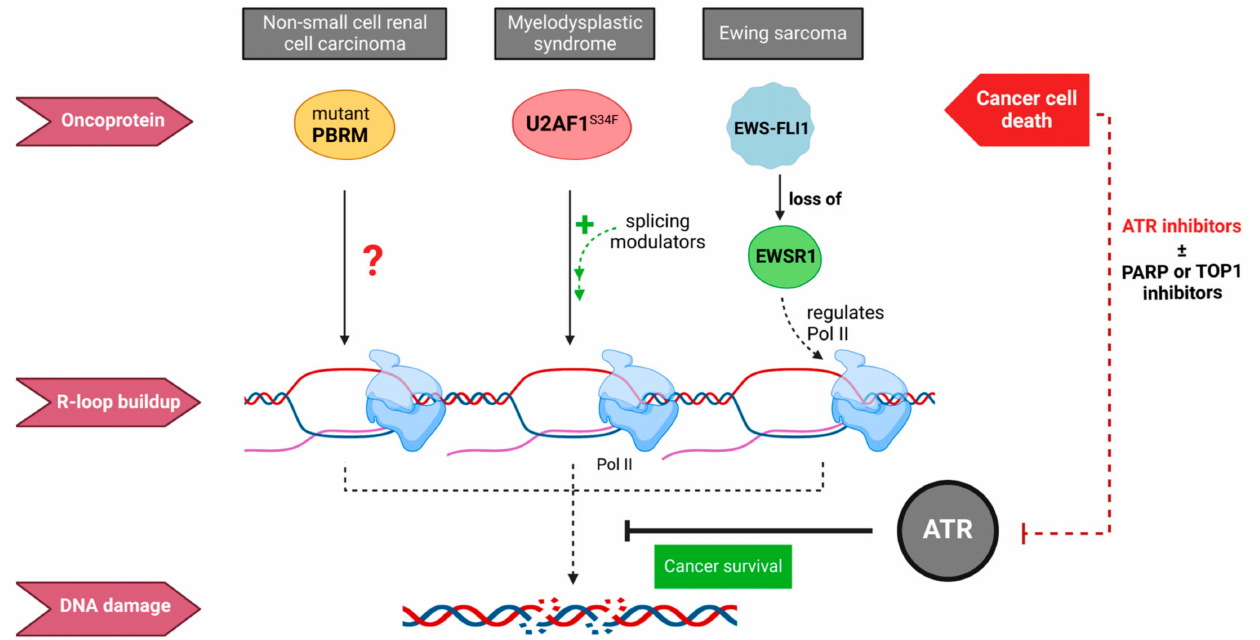
Figure 5. ATR inhibition induces cancer cell death through accumulation of R-loops. Non-small cell renal cell carcinoma caused by PBRM mutations [81], myelodysplastic syndrome caused by a splicing defect in U2AF1 [30], and Ewing sarcoma caused by EWS-FLI1 oncogene fusion [80] and subsequent loss of intact EWSR1 all display increased R-loop levels. Mechanistic details are unclear in PBRM mutations, hence the question mark. Splicing modulators further increase R- loops accumulation in myelodysplastic syndrome cells. A loss of the EWSR1 regulatory effect on Pol II might be causal in Ewing Sarcoma. In all three cancer cells, ATR controls the level of the resulting genomic instability to keep cancer cells viable. In consequence, ATR inhibition alone or in combination with therapies causing further DNA damage can induce critical R-loop accrual and thereby lead to cancer cell death. This mechanism, built on the lethal build-up of R-loops is explored in cancer therapy. ATR (DNA damage sensor): Ataxia telangiectasia-related; PARP (DNA repair protein): poly(ADP-ribo)polymerase; TOP1 (transient breaking and rejoining of